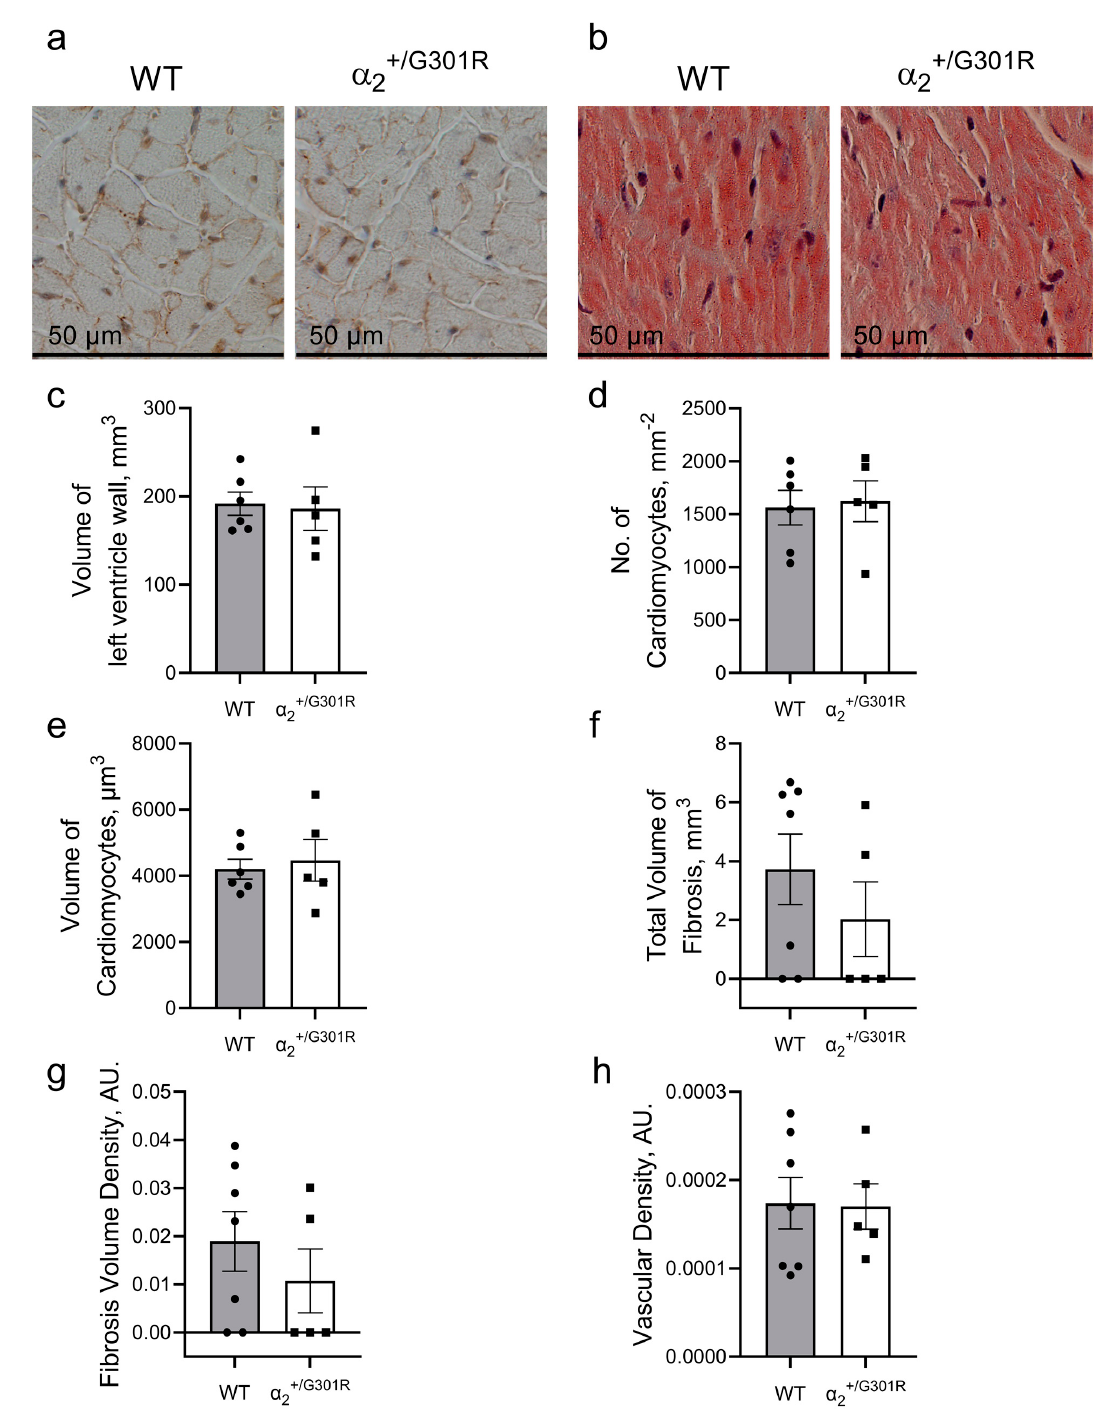
Figure 7. The hearts of 8-month-old α 2+/G301R mice are morphologically similar to those of age- matched WT hearts. The morphology of the left ventricles from aged α 2+/G301R and WT mice were assessed stereologically. ( a ) Representative image of left ventricular tissue from WT and α 2+/G301R hearts that were used for cardiomyocyte characterization. ( b ) Representative Masson’s trichrome staining of WT and α 2 +/G301R heart slices for estimation of fibrosis. There were no differences between the two groups in ( c ) volume of left ventricular wall, ( d ) number of cardiomyocyte profiles per area, ( e ) volume of cardiomyocytes, ( f ) total volume of fibrosis, ( g ) density of fibrosis, or ( h ) vascular density of the left ventricular wall. Data were compared with an unpaired t -test or a Mann–Whitney test. n =